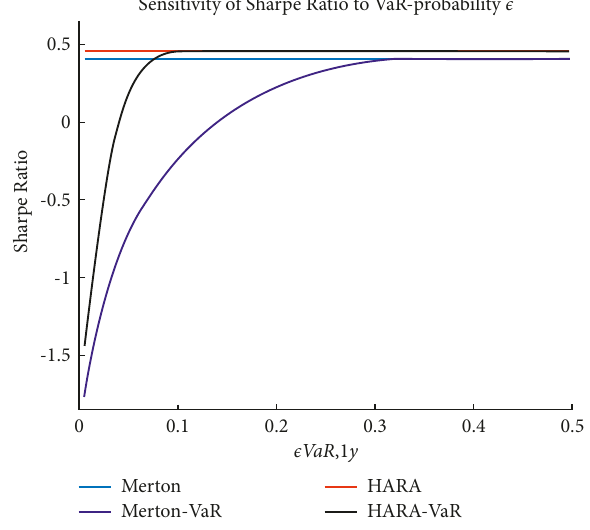
Table 3: Numerical results for variations in ϵ